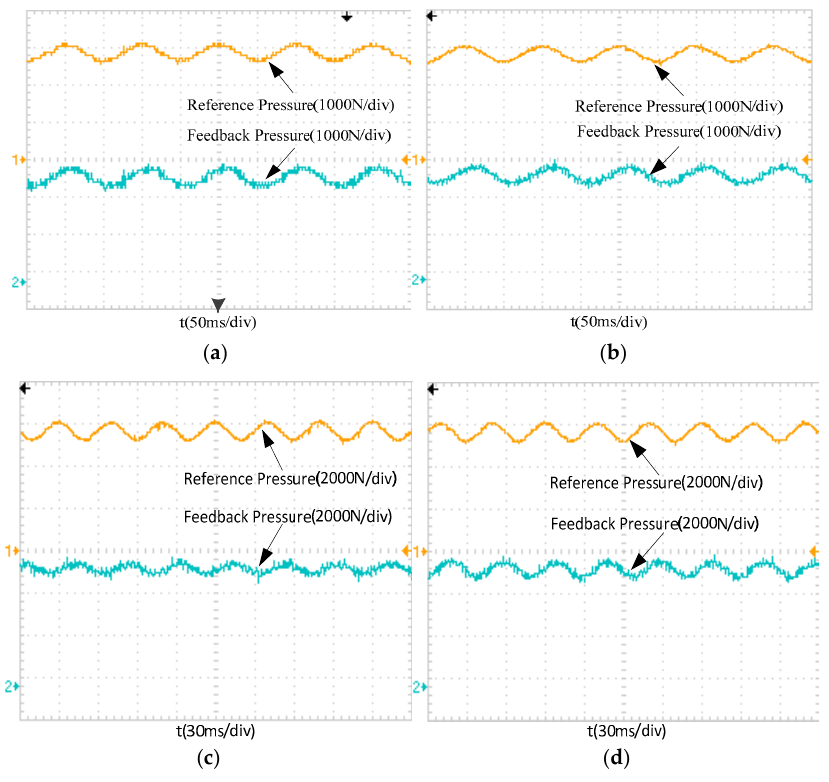
Figure 7. Pressure servo performance comparison. ( a ) PID Control at 10 Hz; ( b ) Proposed Method at 10 Hz; ( c ) PID Control at 25 Hz; ( d ) Proposed Method at 25 Hz.